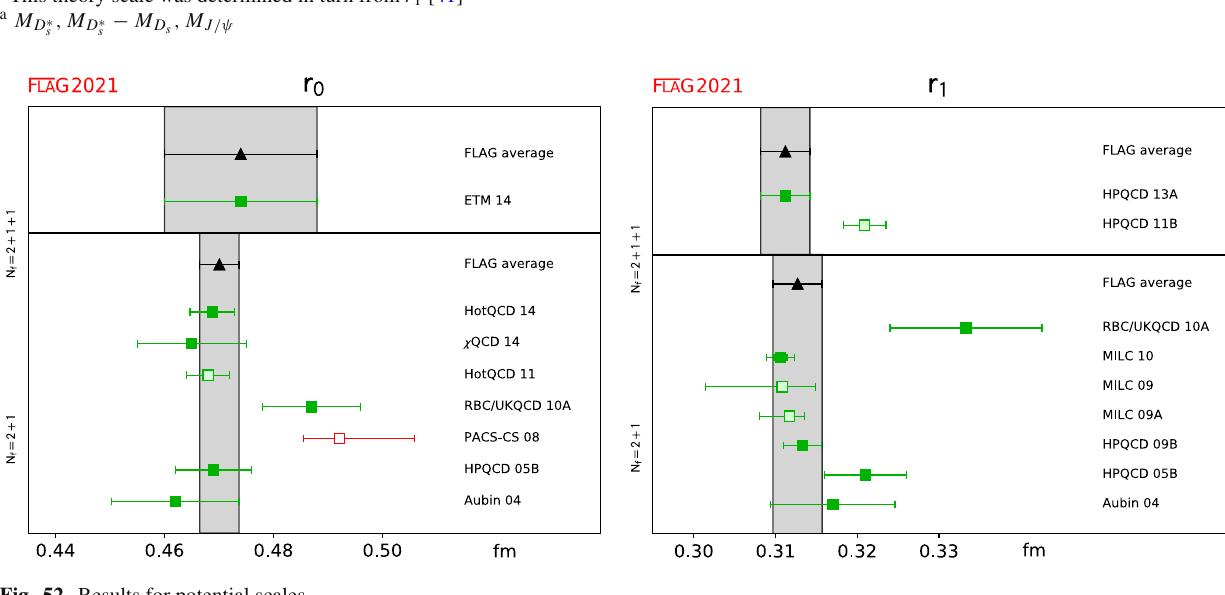
Fig. 52 Results for potential scales